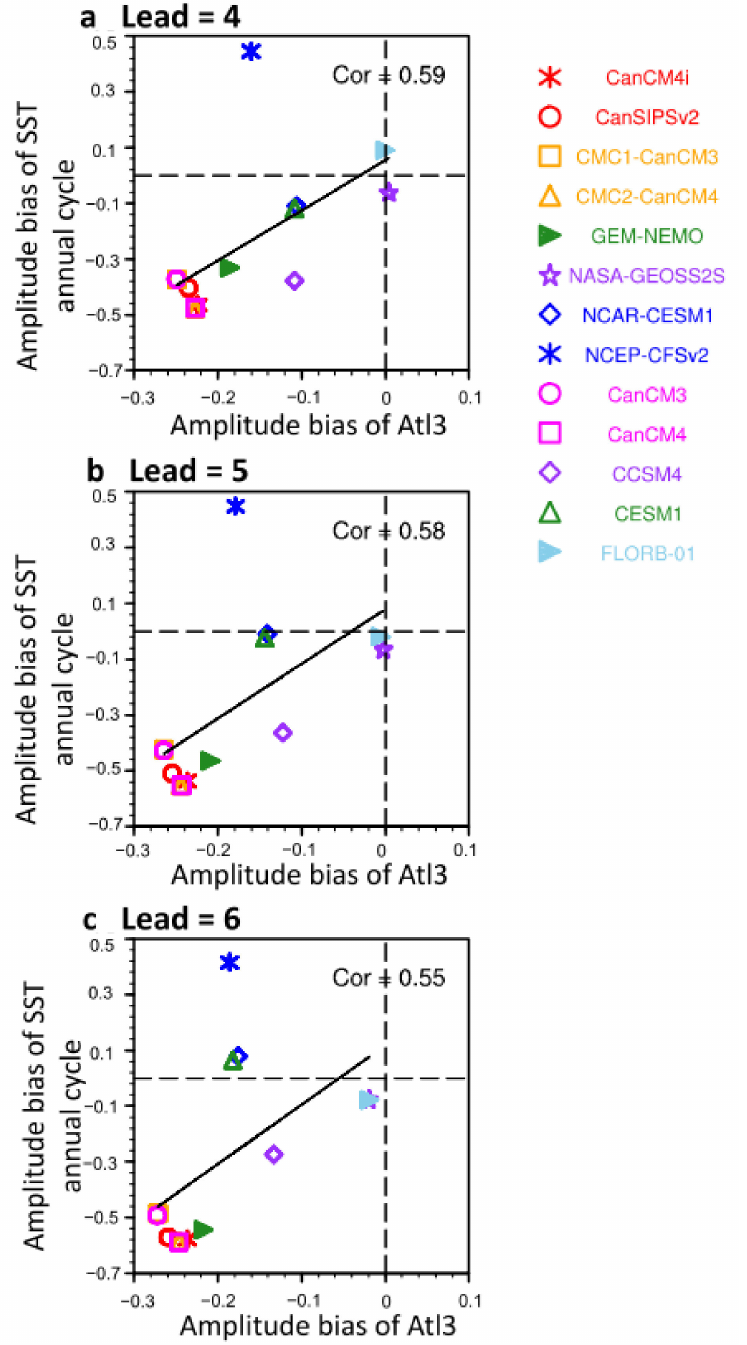
Figure 13. Scatter diagram showing the relationship between the amplitude bias of the predicted Atl3 index ( x -axis) and the amplitude bias of the annual cycle of SST averaged in Atl3 region ( y -axis) for ( a ) four-month-lead forecast, ( b ) five-month-lead forecast and ( c ) six-month-lead forecast. Here the amplitude of annual cycle is defined as the standard deviation from annual mean, and the amplitude bias of SST annual cycle is denoted by the amplitude of SST annual cycle subtracting the counterpart in the observation. The linear regression line is presented in the figure and the correlation coefficient is shown on the top right of each